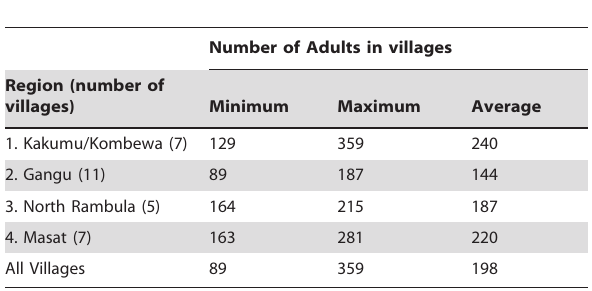
Table 1. Adult populations of 30 villages in the Siyaya district of